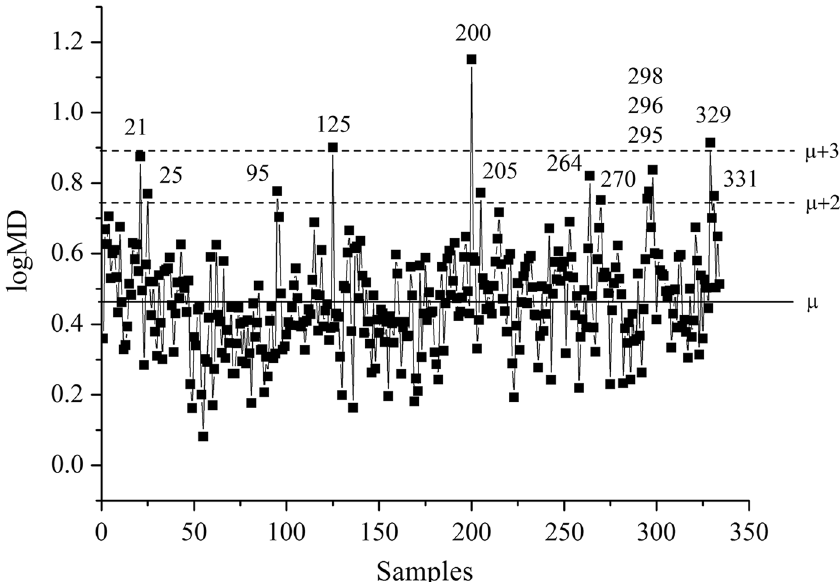
Fig. 1 Chart of logMDs calcu- lated from 11 original variables